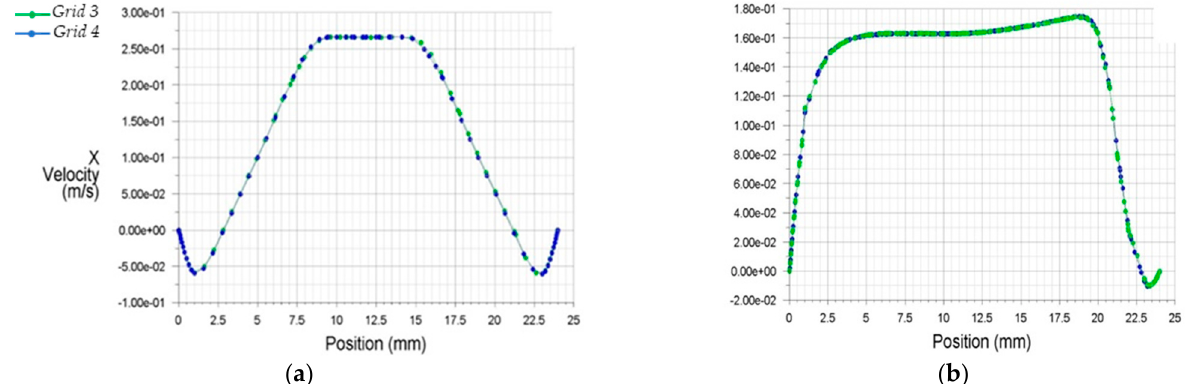
Figure 6. Streamwise x velocity profiles for two condensed grids at two downstream stations from the stenosis ( a ) 0.5D, ( b ) 8.0D.